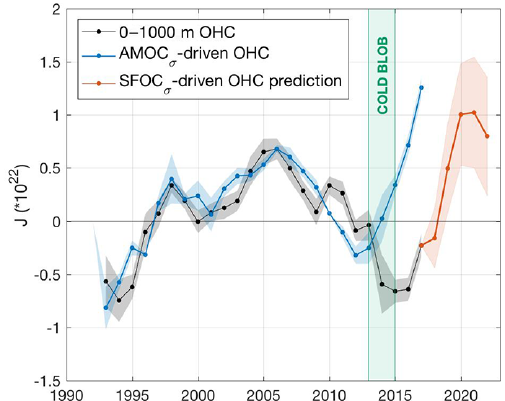
Figure 5. OHC time series. Detrended anomalies in OHC within the upper SPG (0–1000m; 10–70 ◦ W, 45–65 ◦ N; black, in joules) and MHT σ -driven OHC anomalies north of 45 ◦ N (blue, in joules). Shading indicates the ensemble standard errors for each variable. The SFOC σ -driven OHC prediction for 2017–2022 is shown in red, with its associated error based on the historical predictive skills of SFOC σ (Eq. 6). The green patch indicates the “cold blob” era driven by extreme air–sea flux events (Josey et al.,